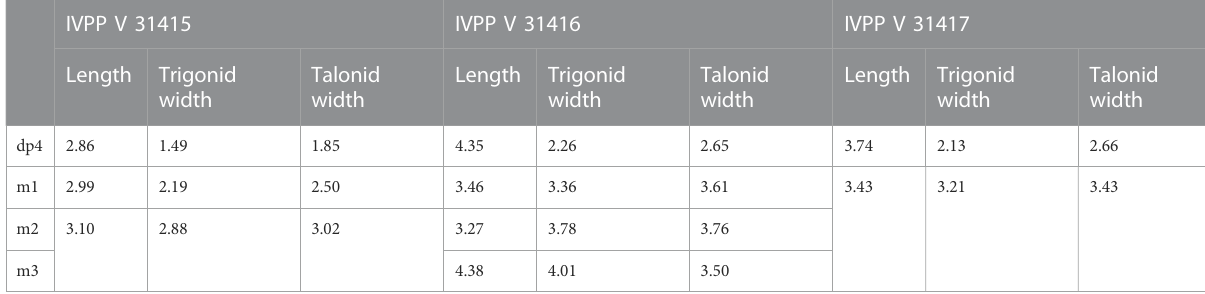
TABLE 1 Measurements of Yuomys jaws discovered from the Gemusi Basin (in